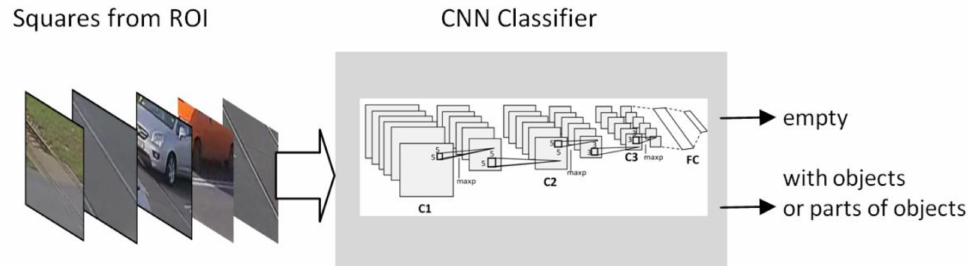
Figure 4. CNN classifier designed for the classification of the contents of the squares.